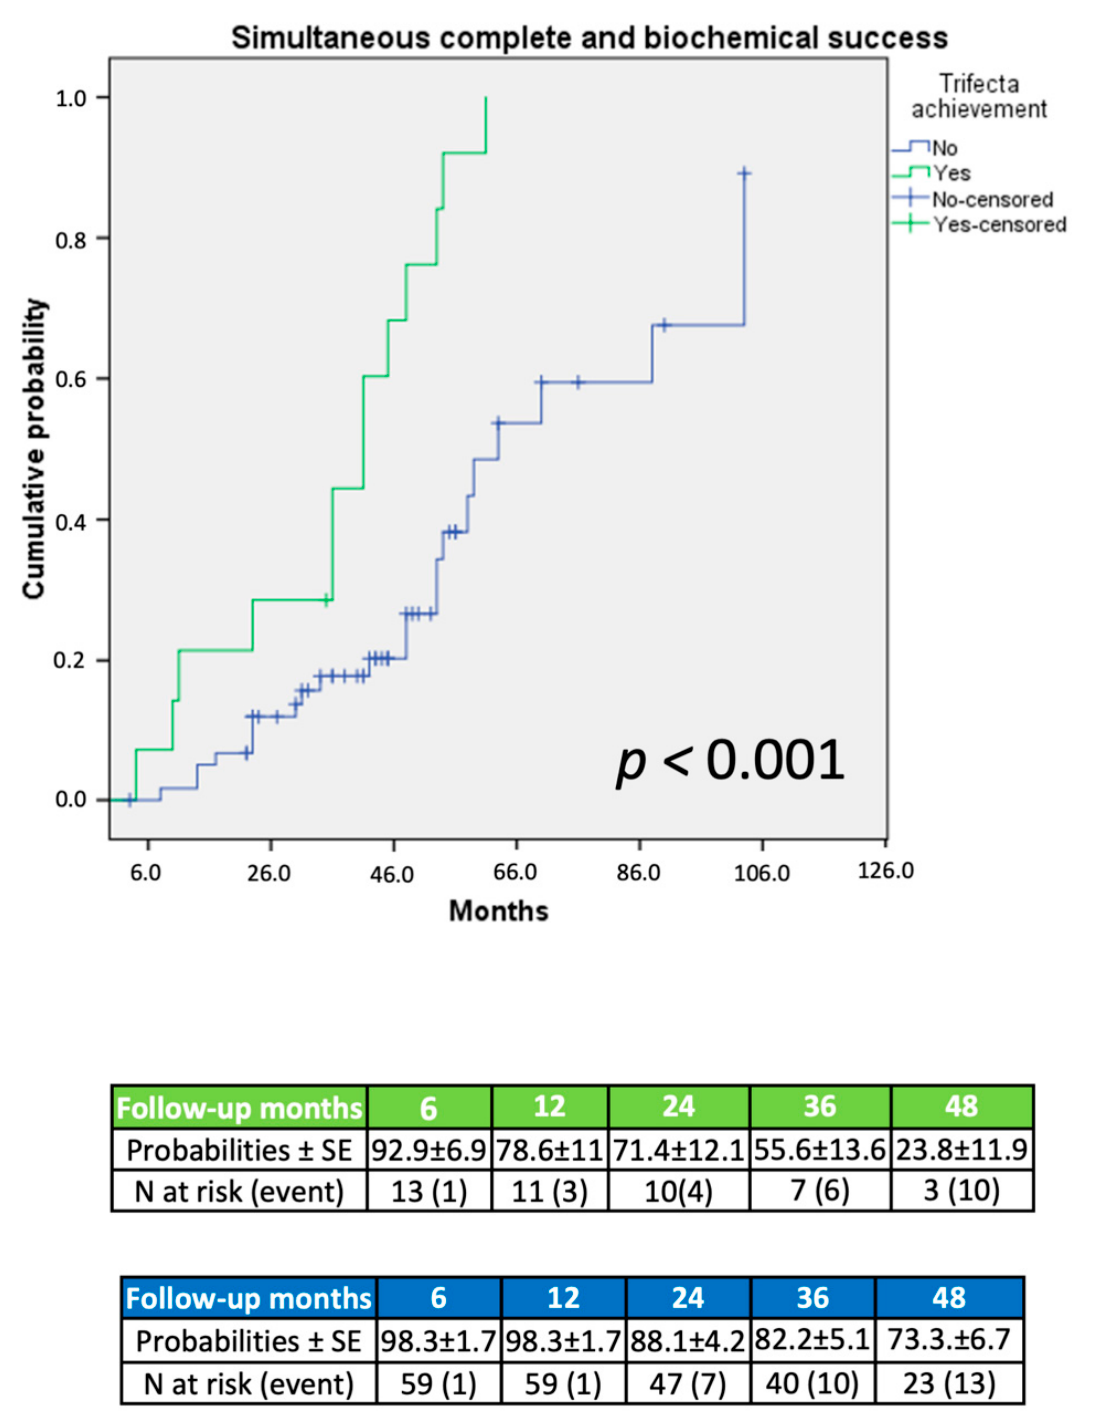
Figure 3. Probability of simultaneous complete clinical and biochemical success according to PASO criteria.